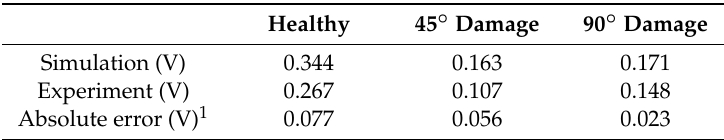
Table 7. Comparison of signal package amplitudes